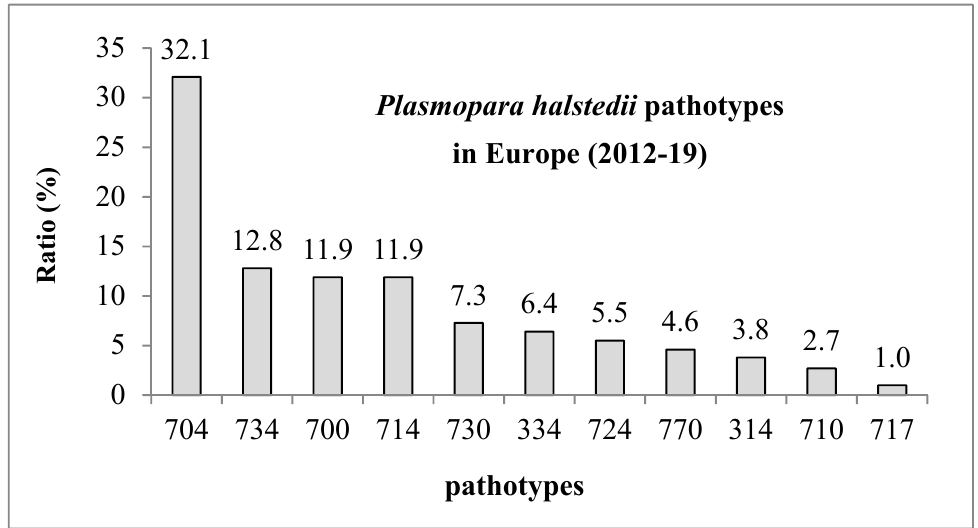
Figure 2. The overall distribution of Plasmopara halstedii pathotypes in 7 countries in Europe (Hungary, Bulgaria, Serbia, Turkey-Thracian, Greece, Romania, and Italy) and Asian region of Turkey (2012–2019). The ratio of pathotypes is based on examining 109 isolates: 70 isolates from Hungary, 10 isolates from Bulgaria, 2 isolates from Serbia, 8 isolates from Turkey, 3 isolates from Greece, 13 isolates from Romania, and 3 isolates from Italy.